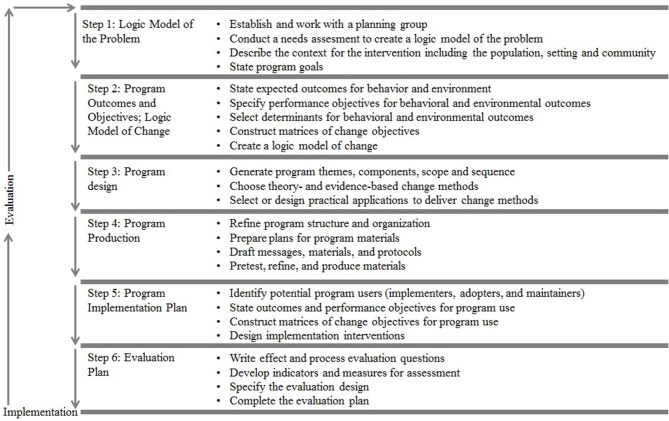
Intervention Mapping steps and tasks (adapted from Bartholomew Eldrigde and colleagues) (10).